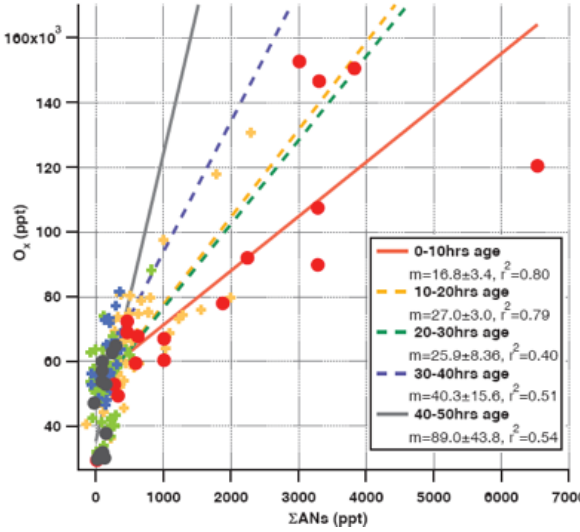
Fig. 6. Observed slopes of 6 ANs v. O x throughout the plume. The freshest points (photochemical age 0–10h) are shown by red cir- cles and the most aged points (photochemical age > 40h) are shown by gray circles. Data from intermediate ages are shown as colored crosses. Lines show the best fits obtained for each age range and slopes are reported along with the 1 σ confidence intervals and r 2 values for each of the